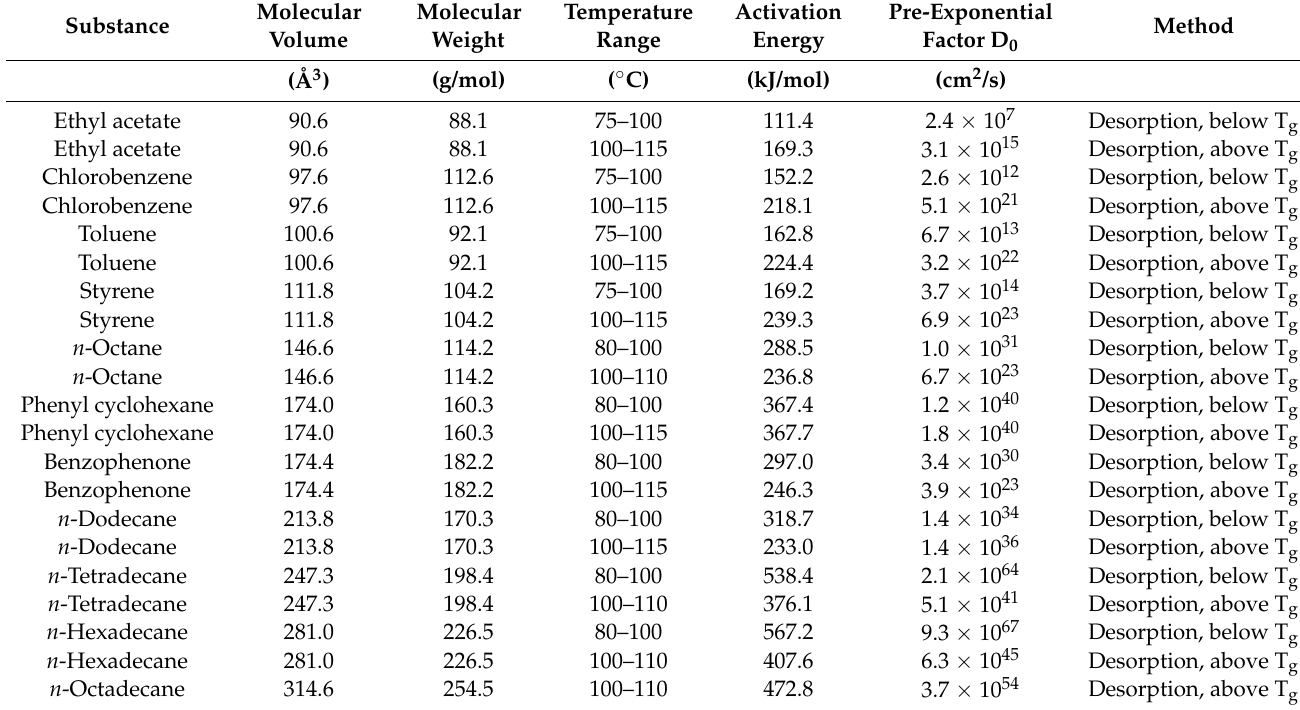
Table 7. Activation energies of diffusion E A and pre-exponential factors D 0 for